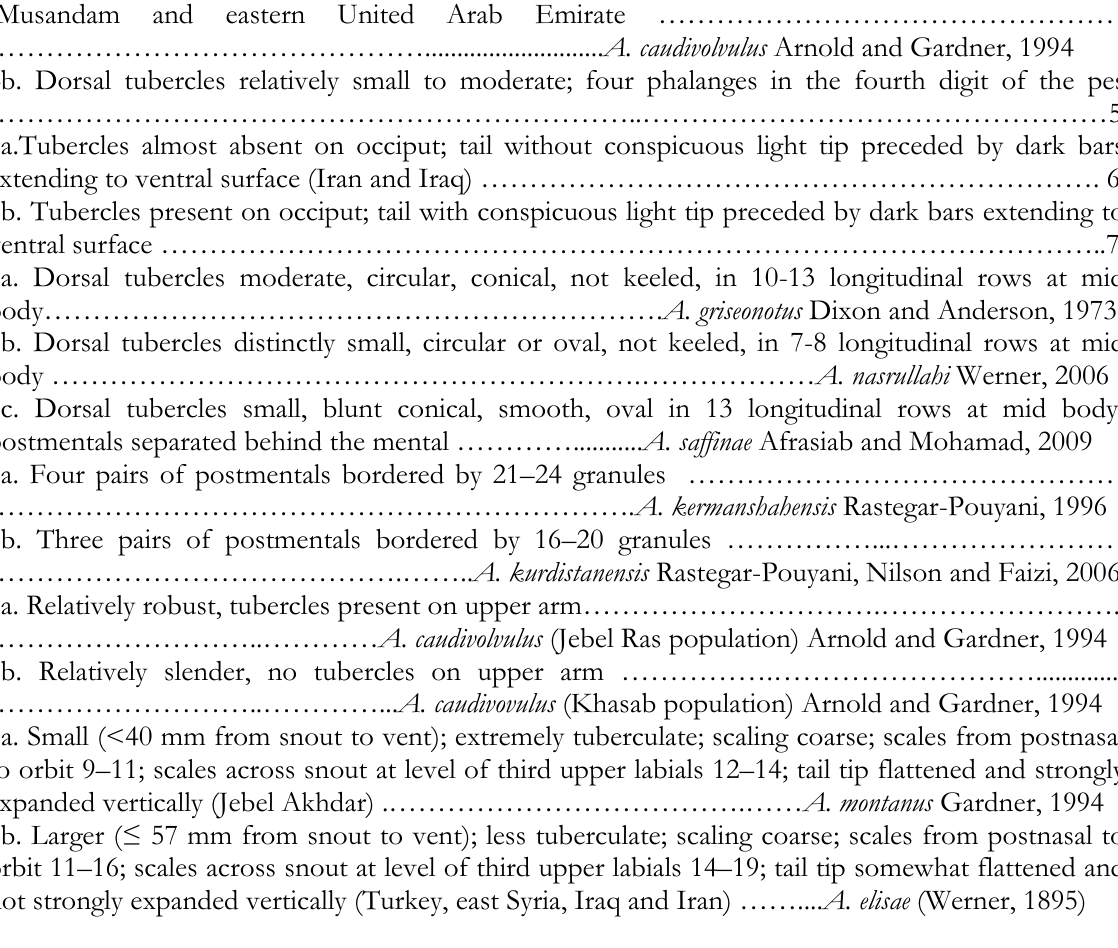
4b. Dorsal tubercles relatively small to moderate; four phalanges in the fourth digit of the pes 5a.Tubercles almost absent on occiput; tail without conspicuous light tip preceded by dark bars 5b. Tubercles present on occiput; tail with conspicuous light tip preceded by dark bars extending to 6a. Dorsal tubercles moderate, circular, conical, not keeled, in 10-13 longitudinal rows at mid 6b. Dorsal tubercles distinctly small, circular or oval, not keeled, in 7-8 longitudinal rows at mid 6c. Dorsal tubercles small, blunt conical, smooth, oval in 13 longitudinal rows at mid body, postmentals separated behind the mental …………........... A. saffinae Afrasiab and Mohamad, 2009